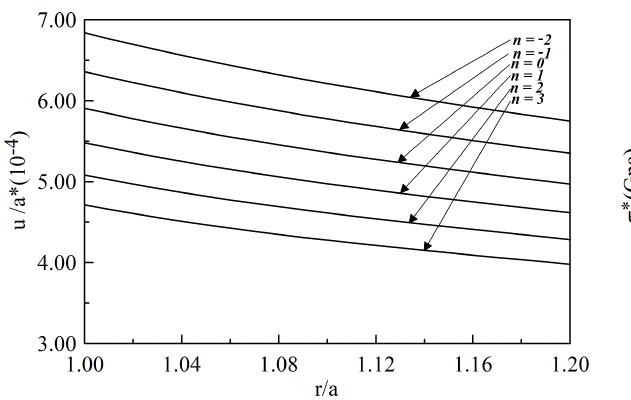
Figure 31: Radially distributed temperature